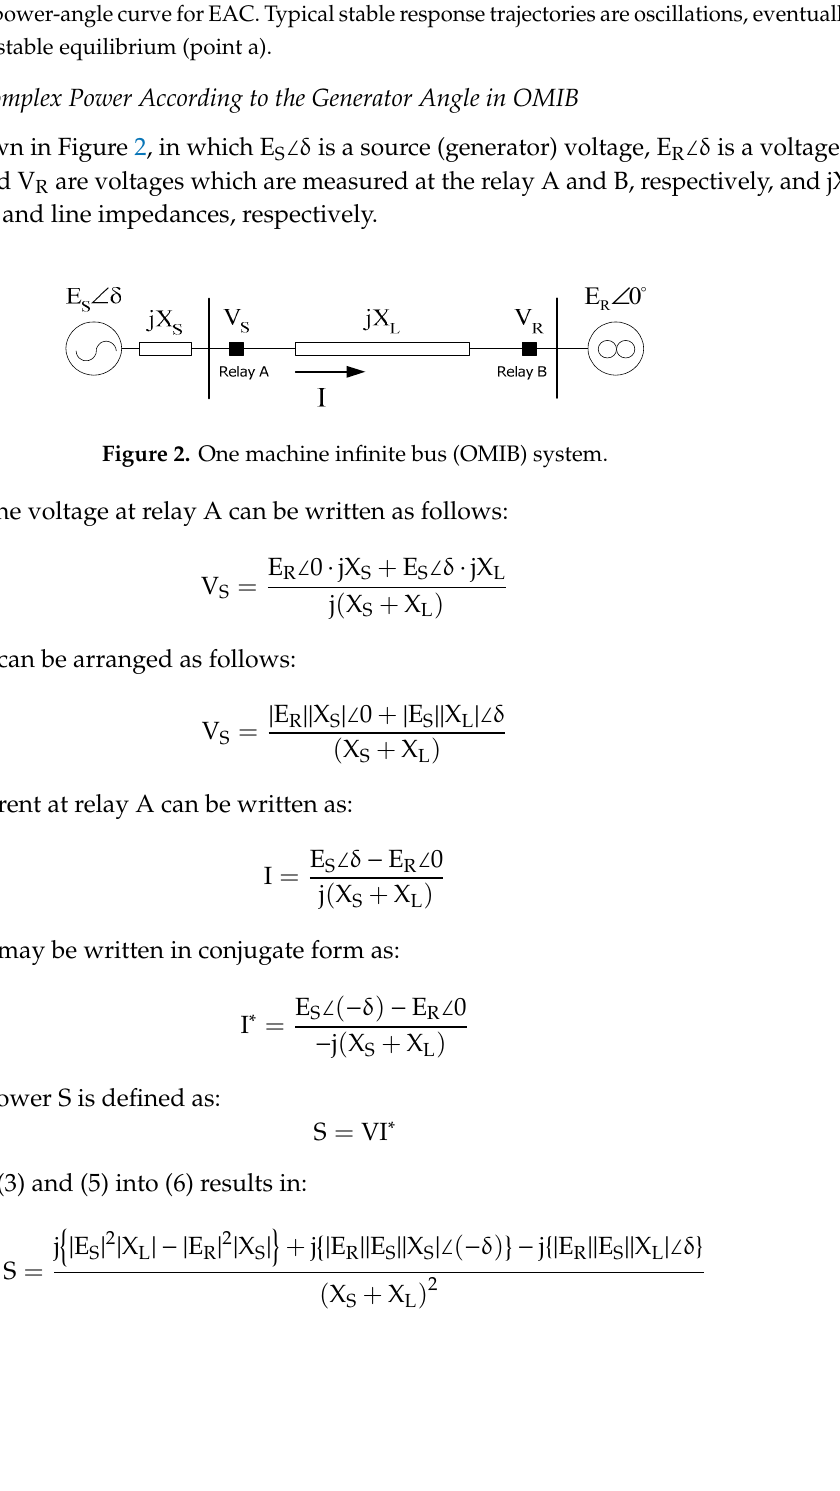
Figure 1. The power-angle curve for EAC. Typical stable response trajectories are oscillations, eventually settling into a stable equilibrium (point a).